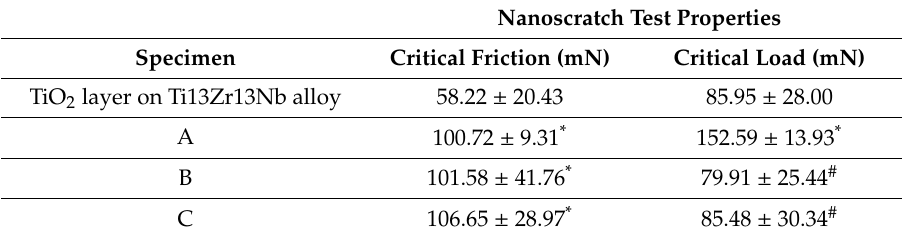
Table 4. Nanoscratch test properties of the TiO 2 layer and chitosan composite coatings (mean ± SD; n =